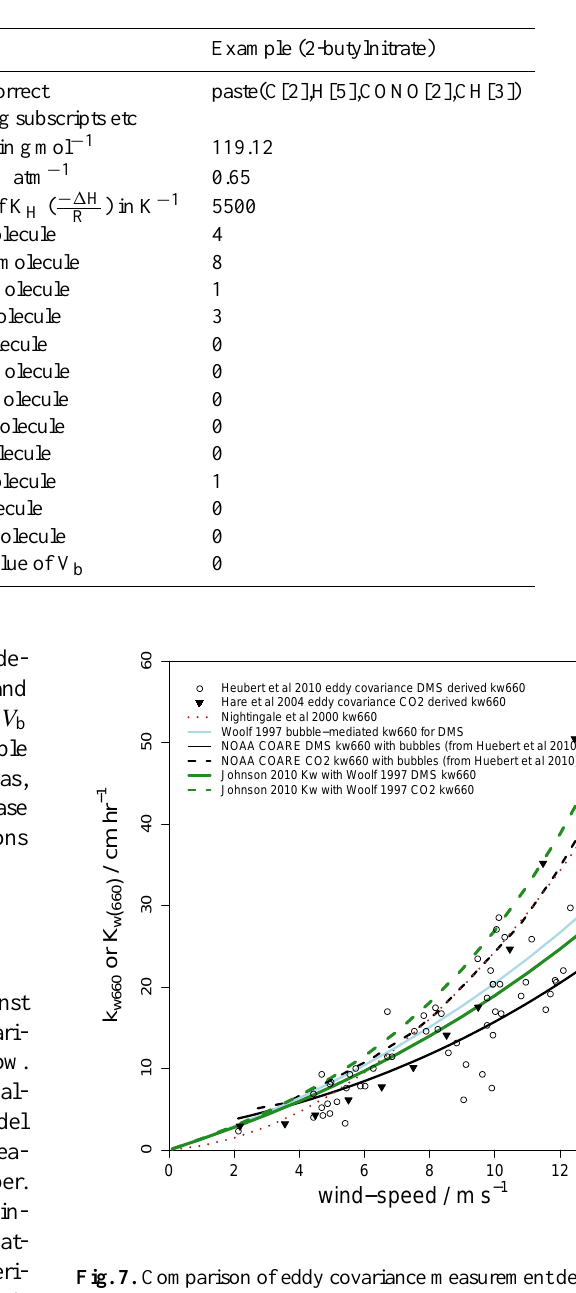
Table 7. Data required for each compound listed in compounds.dat including an example entry. Note that all except the first three are concerned with calculation of V b . If the V b column has a non-zero value, this value will be used for V b and the structural data will be ignored.